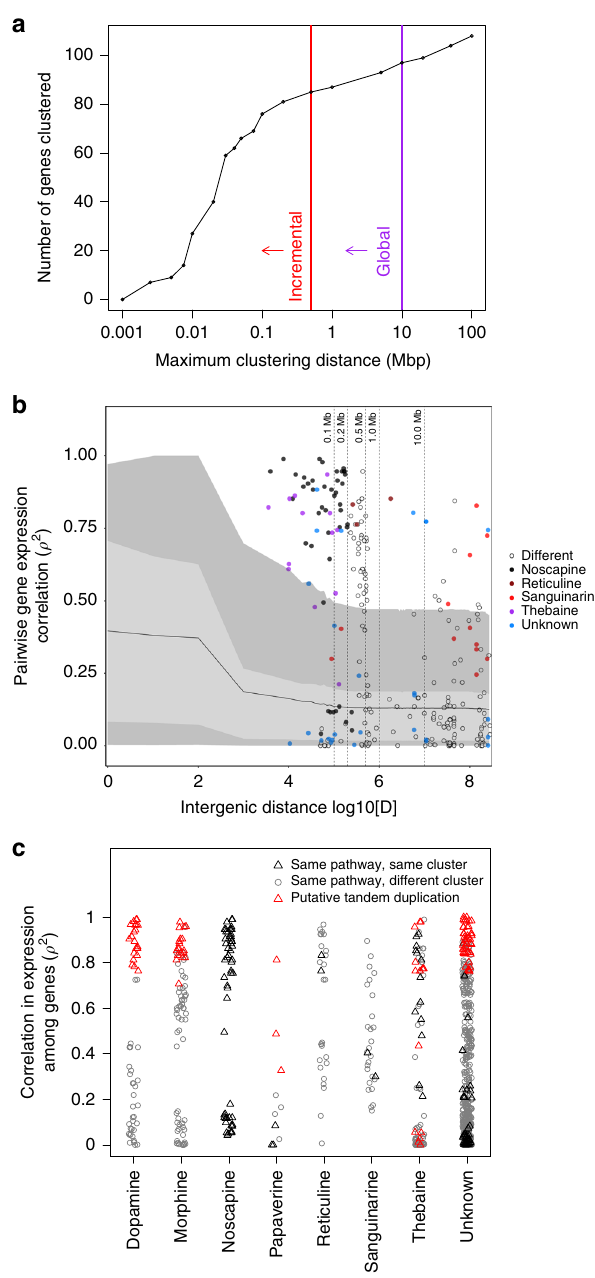
Fig. 3 Clustering and gene co-expression of BIA pathway genes. The incremental and global tests fi nd signi fi cant clustering of BIA genes ( a ). Gene coexpression decays with distance among genes, but is higher for BIA pathway genes ( b ) and higher for genes that are tandemly duplicated or in the same pathway ( c ). Panel ( b ) shows that pairwise gene coexpression between non-BIA pathway genes decreases more rapidly than for BIA genes in the same pathway and even BIA genes in different pathways. In ( b ) the dark gray regions represent the 75th – 95th and 5th – 25th percentiles, the light gray regions represent the 25th – 75th percentiles, and the black solid line represents the 50th percentile. Source data are provided as a Source Data fi